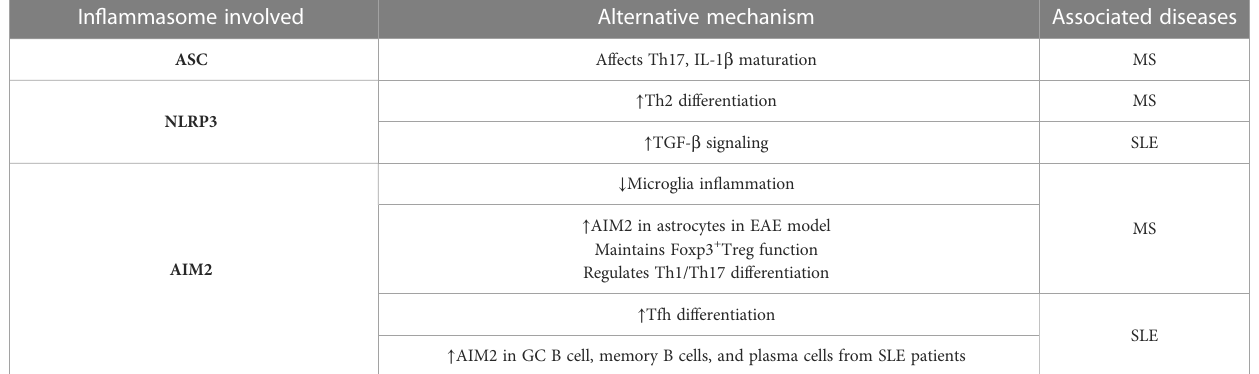
TABLE 2 Alternative functions of in fl ammasome molecules in autoimmunity. In fl ammasome